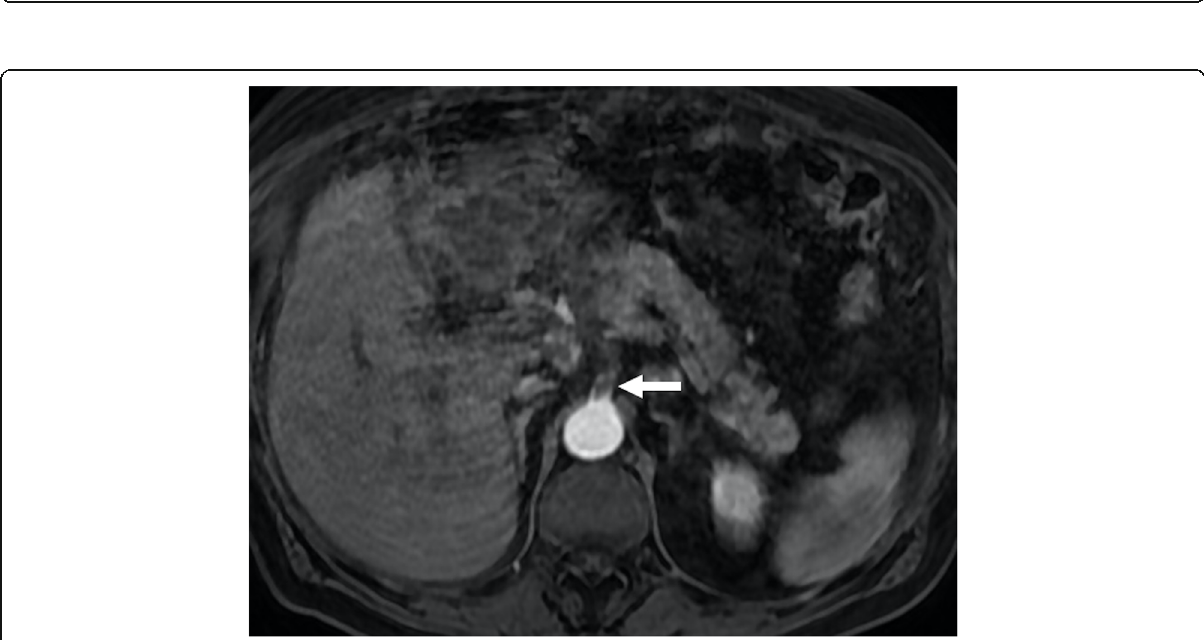
Fig. 27 Celiac artery thrombosis. A 64-year-old male with known colon cancer treated with chemotherapy presented with severe epigastric pain and elevated liver enzymes. Axial plane post-contrast arterial phase T1W image shows intraluminal thrombus completely obstructing the celiac artery lumen (arrow). There was no extension of this thrombus into the aorta. Also, note was made of associated splenic infarcts (not